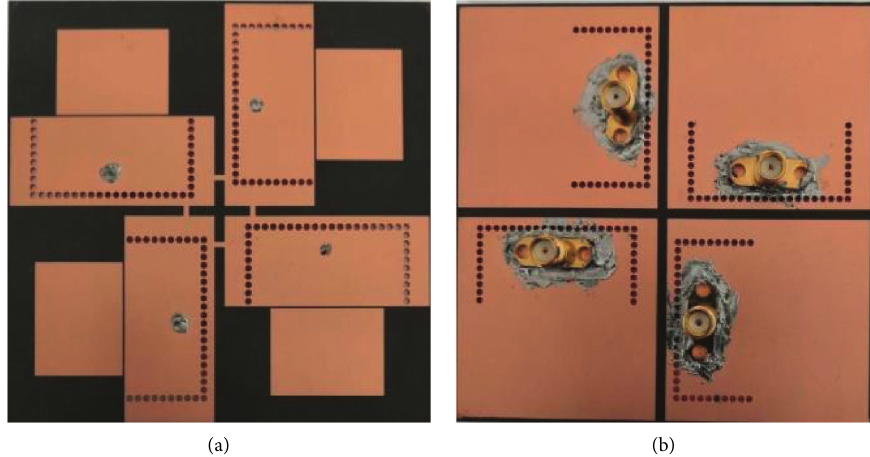
Figure 11: Photograph of the fabricated MIMO antenna with SNLs. (a) Top view and (b) bottom view.